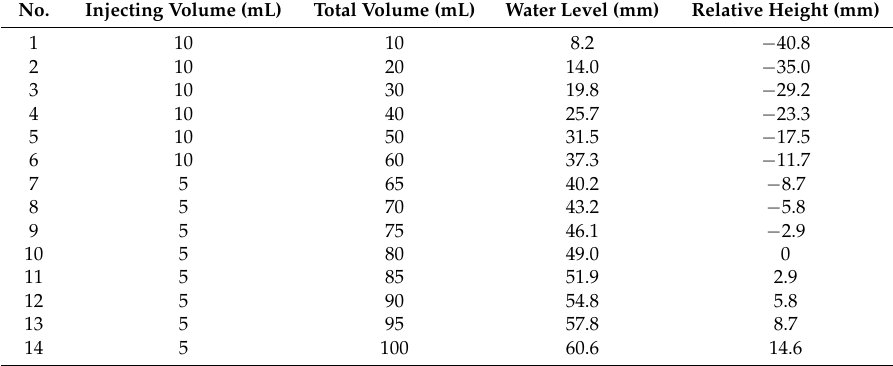
Figure 4. Operation to measure the effective scope of the electrode’s electric field. ( a ) Level influence depth experiment device; ( b ) vertical impact experiment device; ( c ) level influence depth experiments, based on water injection outside introversion; and ( d ) level influence depth experiments, based on outside-in water injection. Table 1. Volume of injected DD during points where the vertical electric field affects the measurements *. No.